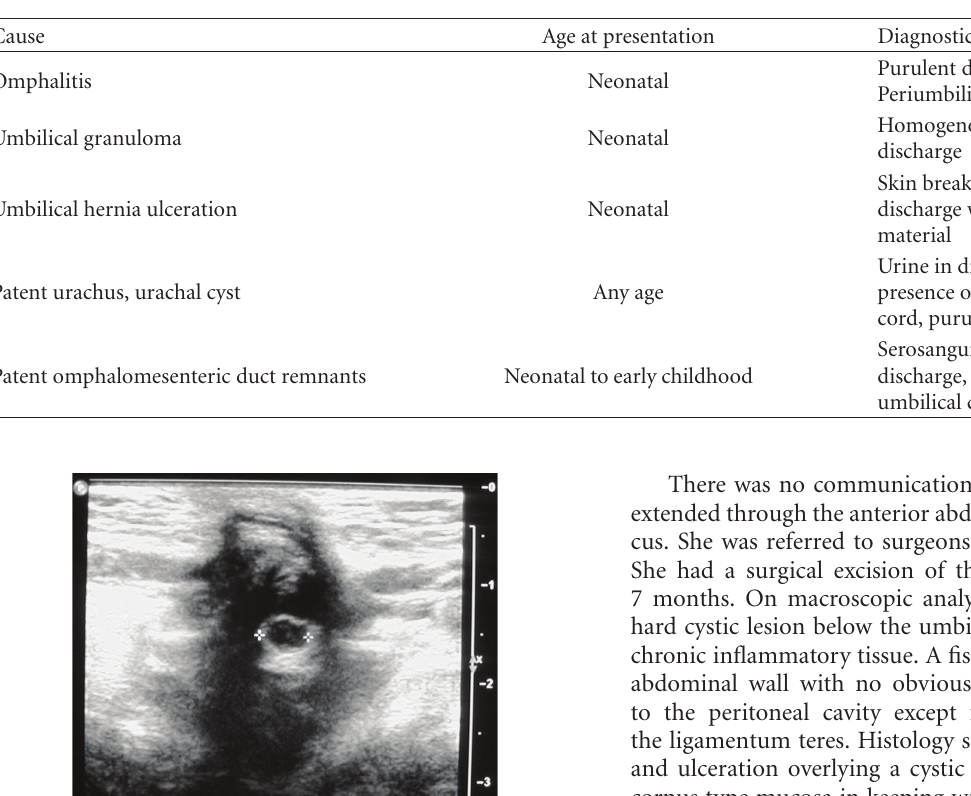
Table 1: Di ff erential diagnosis of umbilical discharge.